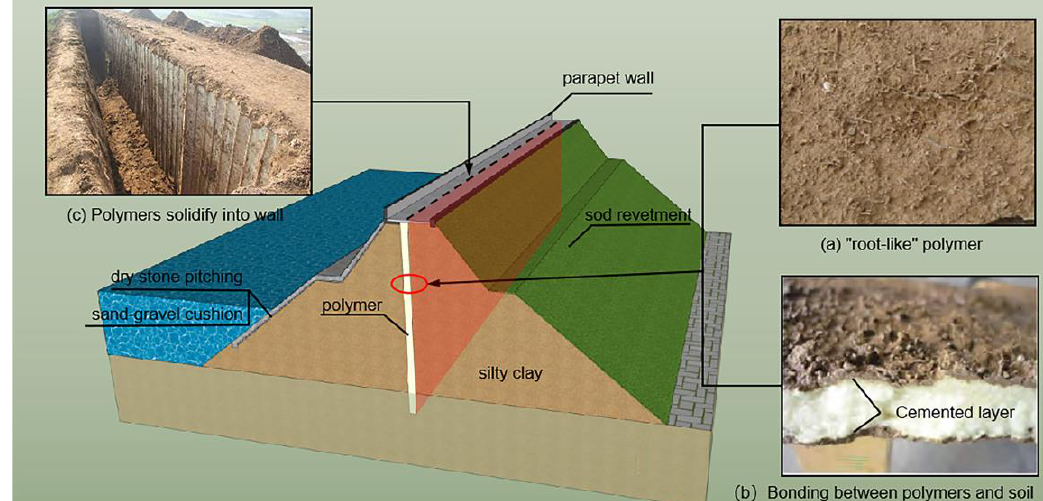
Figure 1. Construction technology of polymer anti-seepage wall.